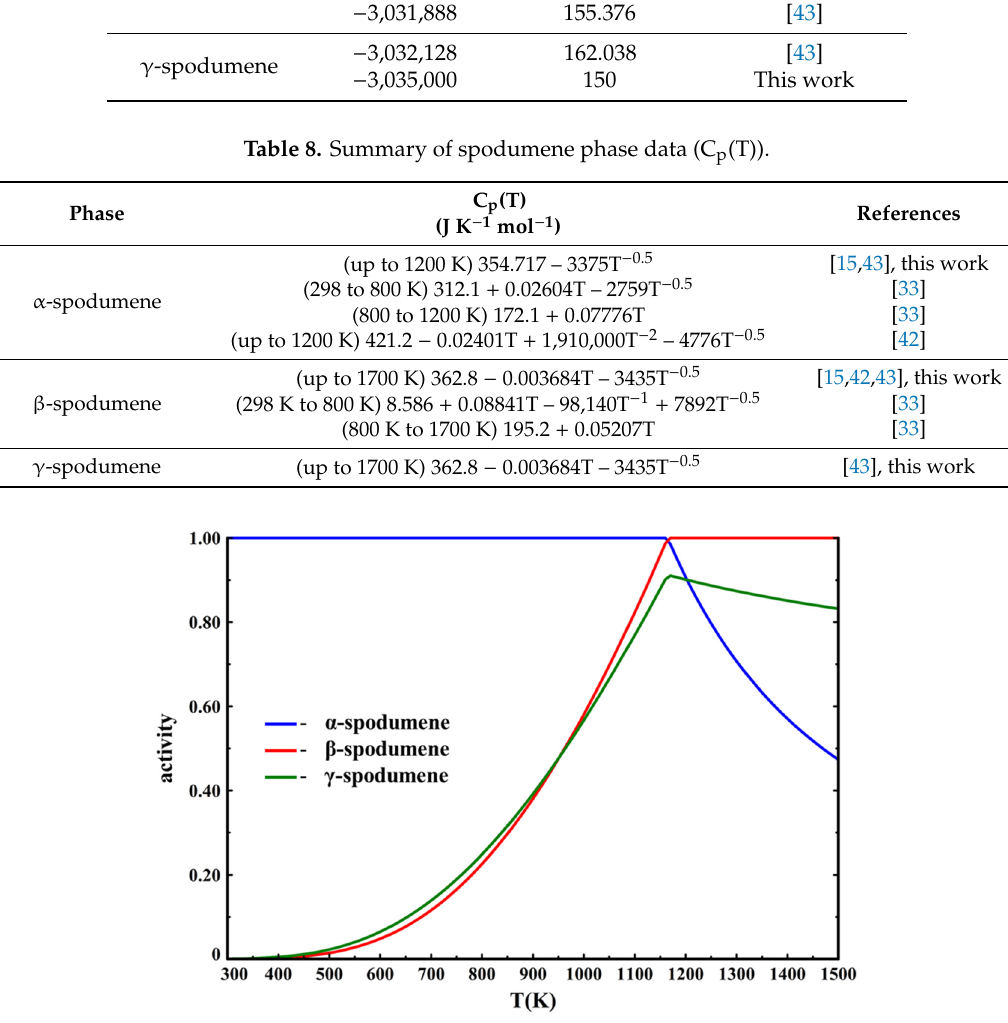
Table 7. Summary of spodumene phase data ( Δ H 298 and S 298 ) .